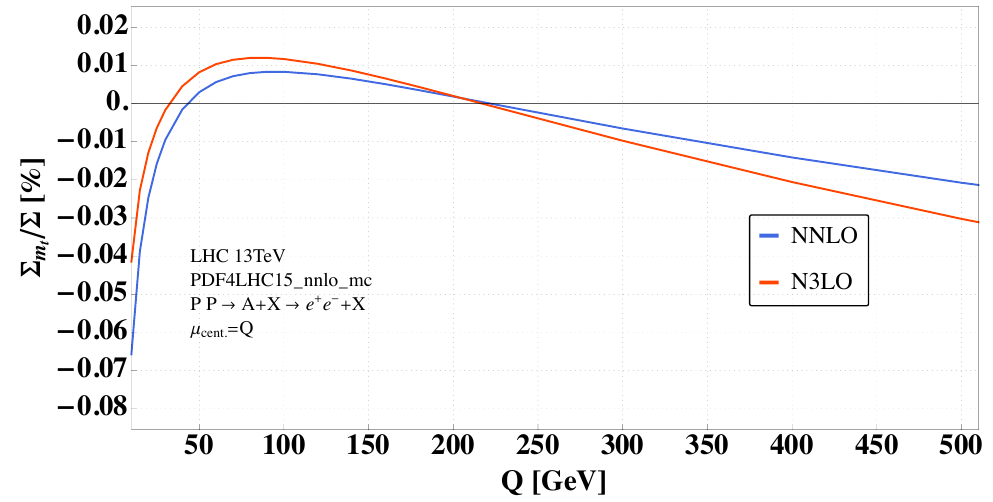
Figure 18. Relative contribution from the non-decoupling top-mass effects as a function of Q up to different order in perturbations